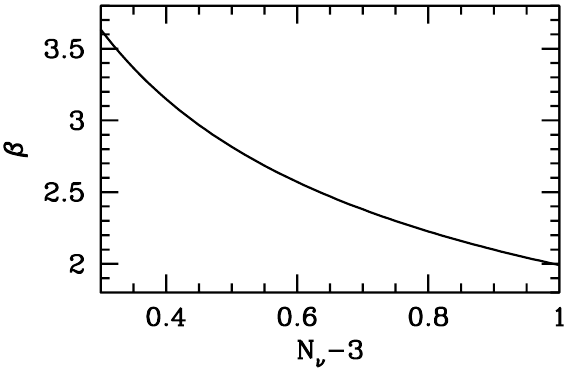
Figure 3. Values of the coupling β corresponding to given values of Dark Radiation , expressed in terms of extra neutrino species. This plot is valied during